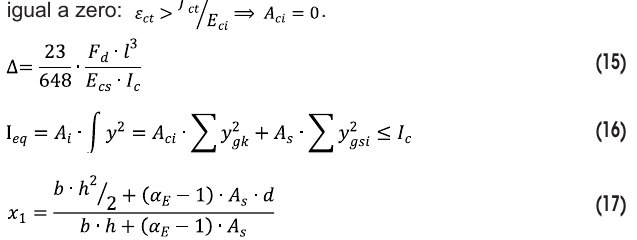
Na Figura 15 é apresentado o resultado da análise para as vigas de concreto armado com e sem fibras de aço em termos de força (F ) versus deslocamento vertical ( ∆ ). d l = vão da viga; E = módulo de elasticidade secante; I cs de inércia da seção bruta. Para a seção fissurada, é adotado o momento de inércia equivalente a partir da integração numérica da seção (Figura 12a).